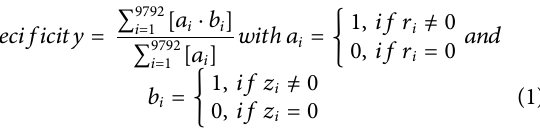
Frontiers in Pharmacology |